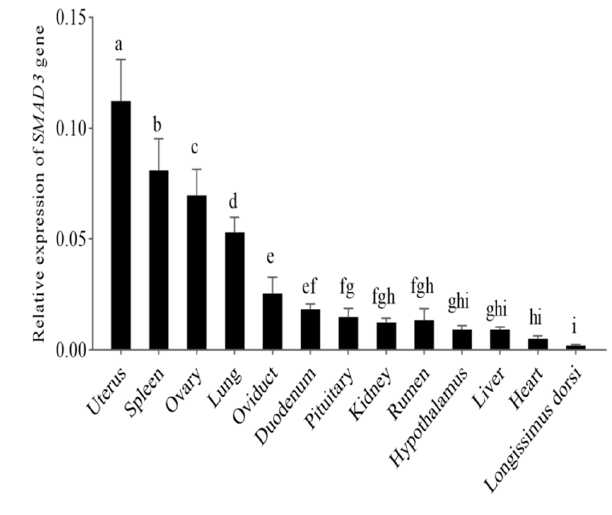
Figure 5. The mRNA expression of SMAD1 , SMAD2 and SMAD3 genes in different tissues of Tibetan sheep. Bars with different letters indicate values with significant differences (n = 3) ( p < 0.05).